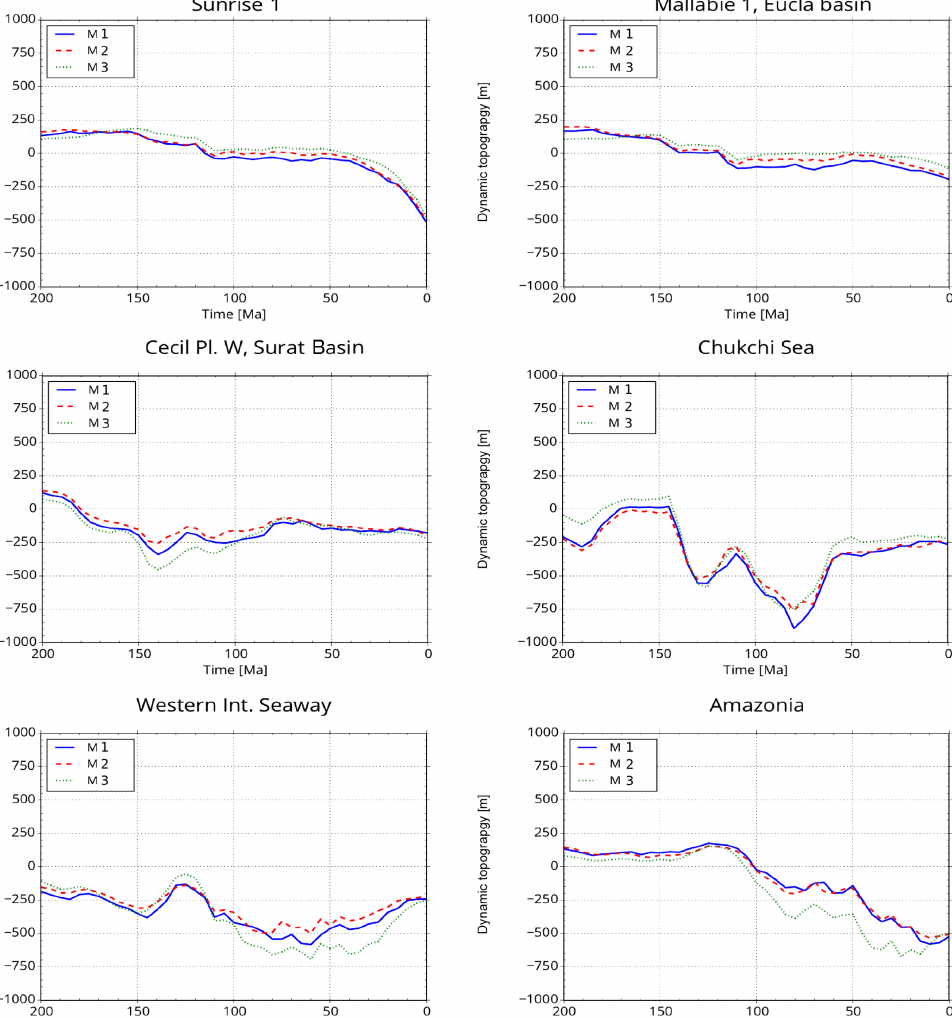
Figure 3. Dynamic topography time series of selected locations for all three models (M1–M3). Vertical motions are dominated by the plate tectonic history, while variations in core–mantle boundary temperature (M2) and lower mantle viscosity (M3) have only marginal effects on dynamic topography. For locations of sample points, see Figs. 11 and